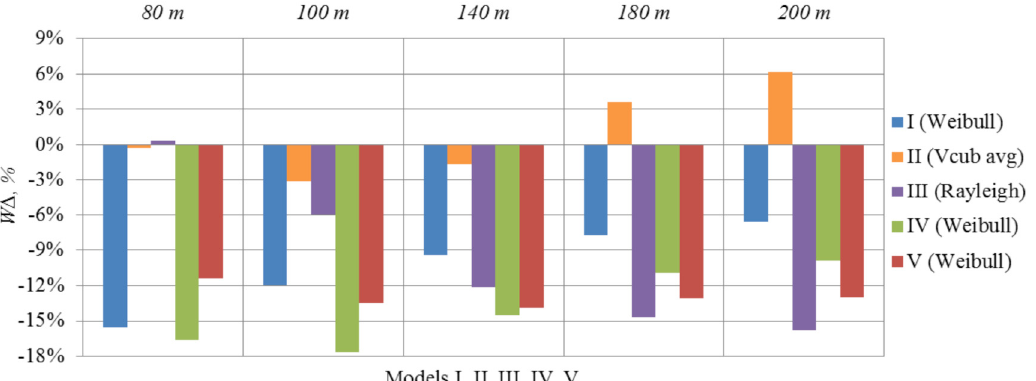
Fig. 5. Relative de fl ection W D (%) of AEP calculation based on models I (cid:2) V for the heights 80, 100, 140, 180 and 200 (m).